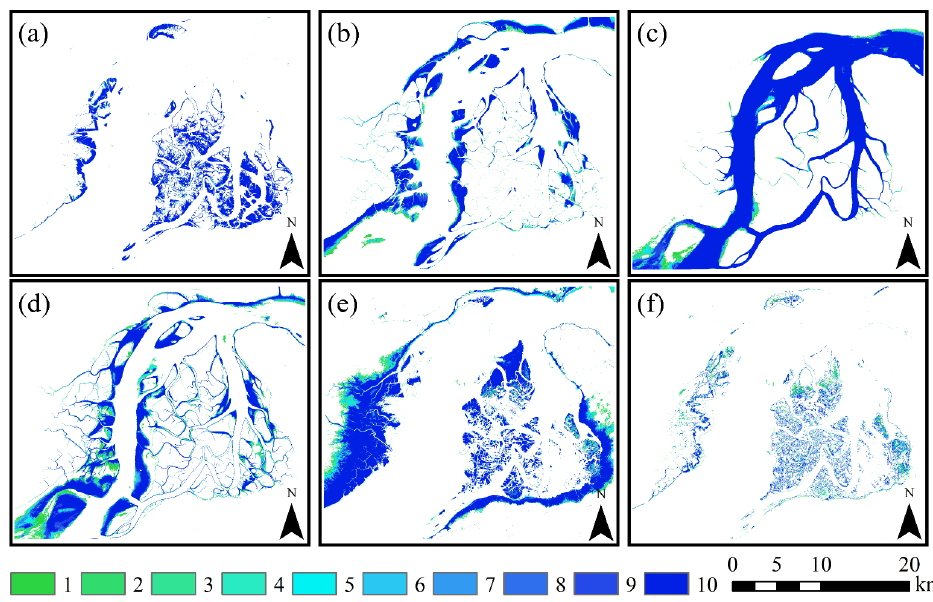
Figure 4. Consistency images of six classes ( a ) mangrove, ( b ) tidal zone, ( c ) deep water, ( d ) shallow water, ( e ) mudflat, and ( f ) aerial roots in the mangrove ecosystem. The consistency values ranged between one and ten, indicating very low and very high consistency, respectively.